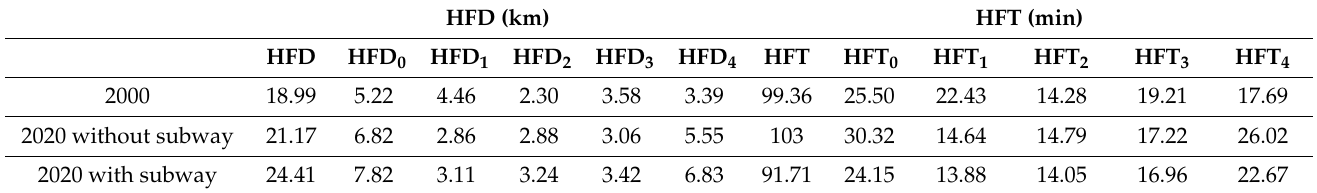
Table 3. Average area weighted travel distance and time of Nanning City in 2000 and 2020.